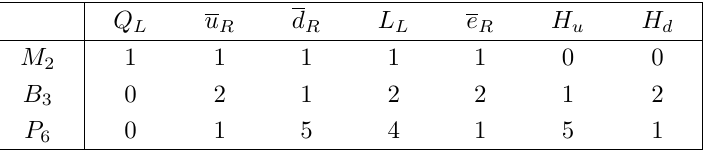
Table 3 . Charges under R-parity M 2 , baryon triality B 3 and proton hexiality P 6 . Some combinations of baryon/lepton number violating operators are severely constrained by proton decay. The limits on the baryon/lepton number violating operators are